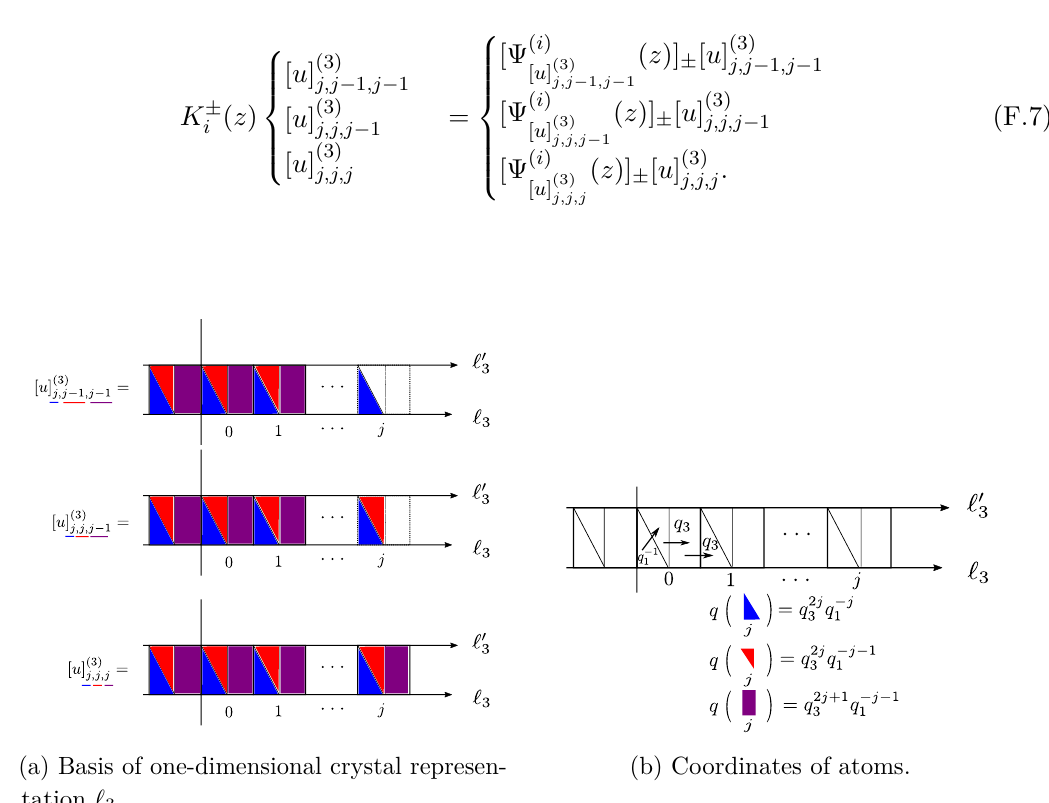
(b) Coordinates of atoms.